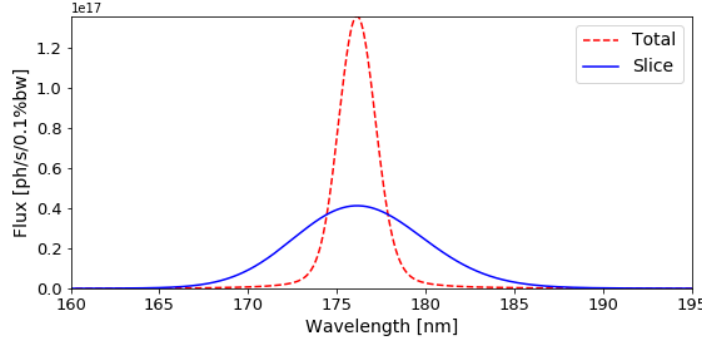
Figure 2. SRW simulations of the spectral flux using the beam parameters of Table 3 for the total beam (blue) and slice beam (red). Window aperture of 1 mm x 1 mm placed at a distance 10 m from the center of the undulator. K u =